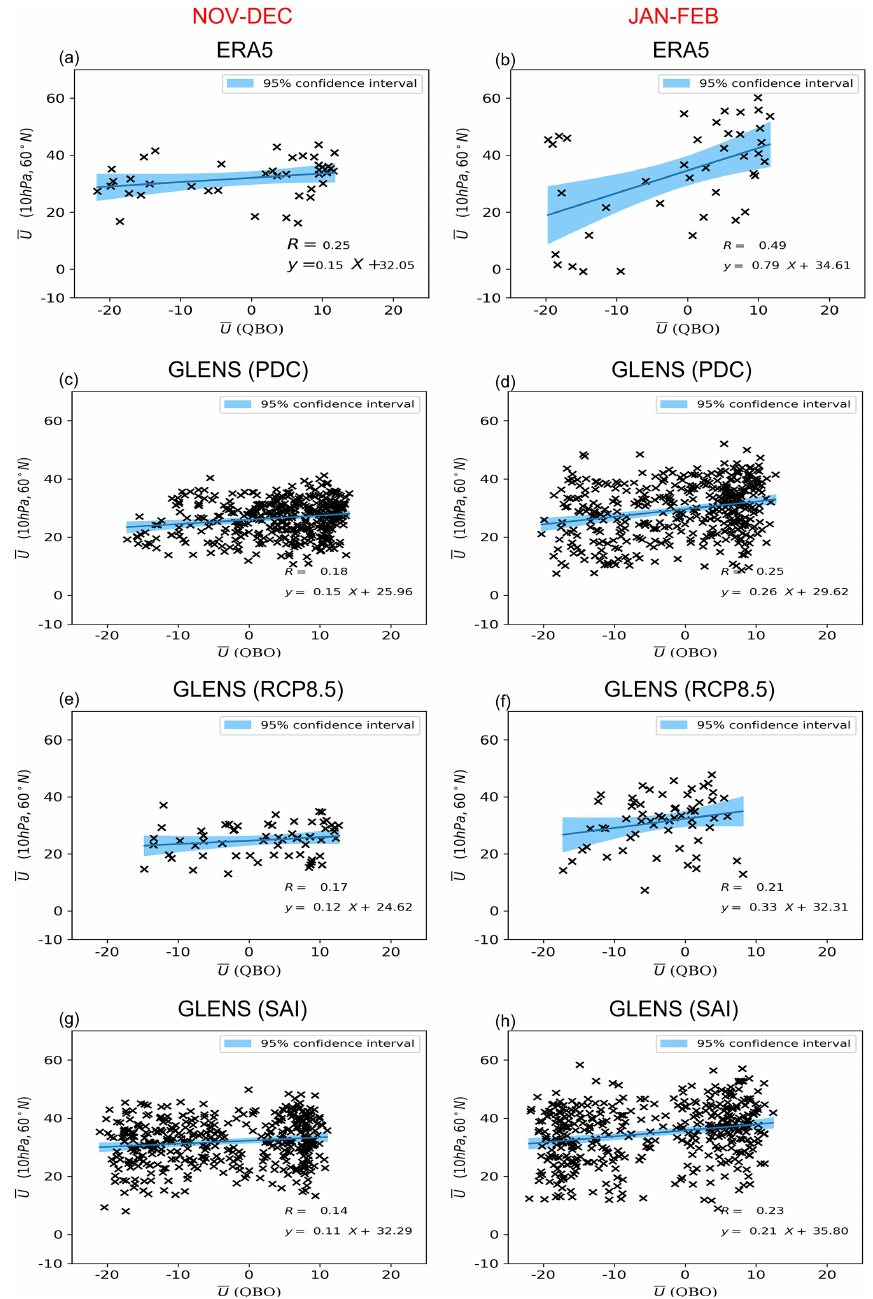
Figure 2. Scatter plot of the strength of the stratospheric polar vortex at 10hPa versus the strength of the equatorial zonal-mean zonal wind in ERA5 (QBO defined at 50hPa) and GLENS (QBO defined at 35hPa) simulations. Text in each panel gives the results of an ordinary least squares regression through the points. The shaded areas show the 95% confidence